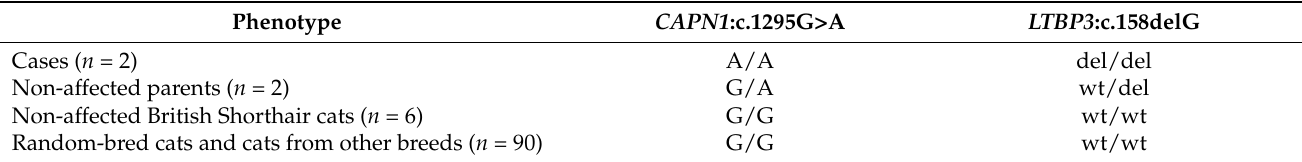
Table 2. Association of the genotypes at the CAPN1 and LTBP3 variants with the skeletal